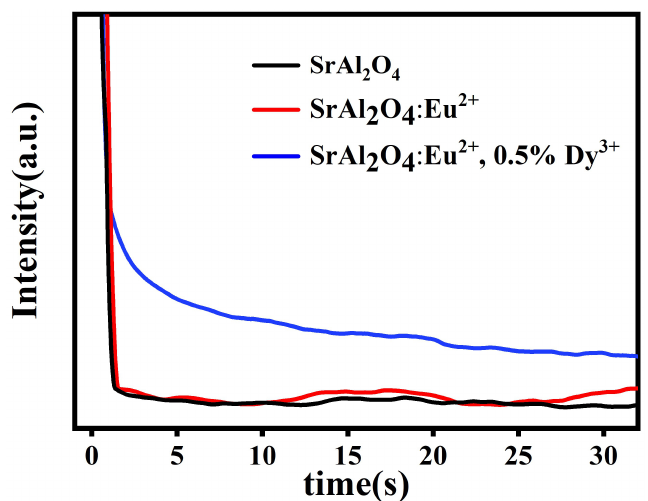
Figure 8. Afterglow of each sample under